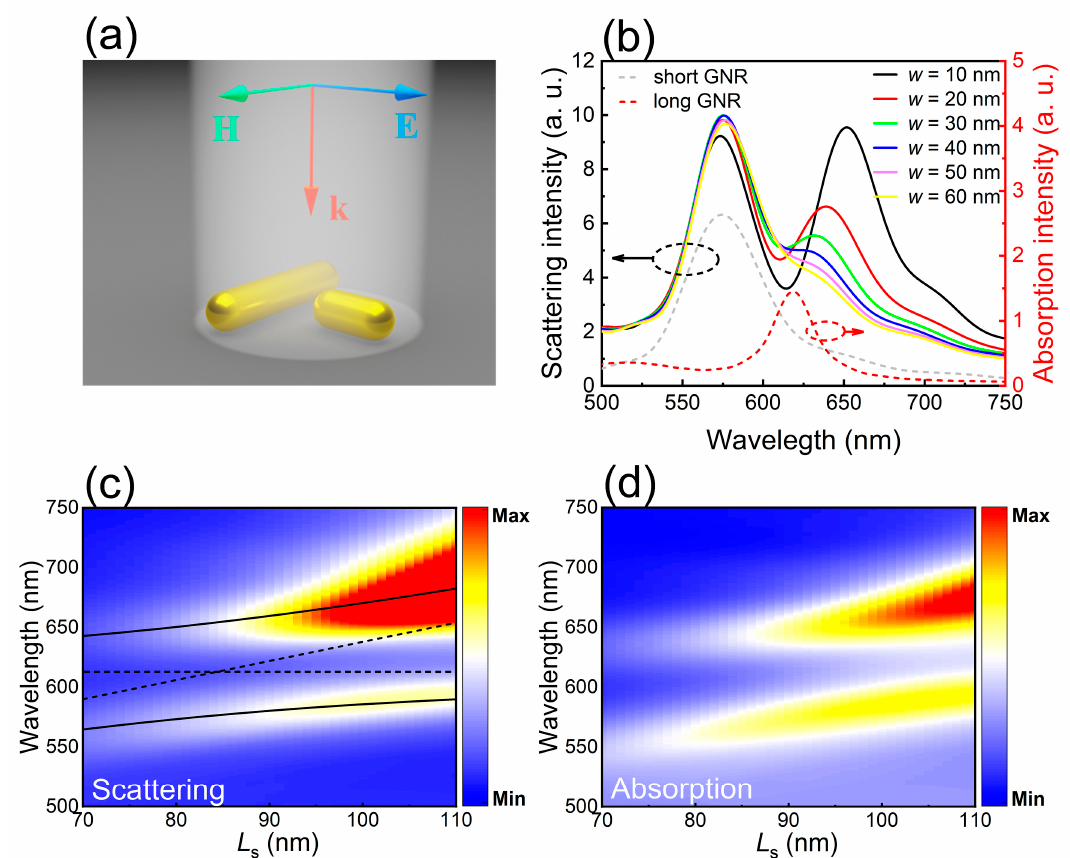
Figure 2. Strong coupling between the dipole and quadrupole modes excited in a T-shaped GNR dimer. ( a ) Schematic showing the T-shaped GNR dimer composed of a long and a short GNR and the wavevector and the electric/magnetic field of the plane wave used to excite the GNR dimer. ( b ) Scattering spectra calculated for GNR dimers with different gap widths ( w ). The scattering spectrum of the isolated short GNR (gray dashed curve) and the absorption spectrum of the isolated long GNR (red dashed curve) are also provided. ( c ) Two-dimensional scattering spectra calculated for GNR dimers composed of short GNRs with different lengths. The fitting results based on Equation (1) are also provided. ( d ) Two-dimensional absorption spectra calculated for GNR dimers composed of short GNRs with different lengths.